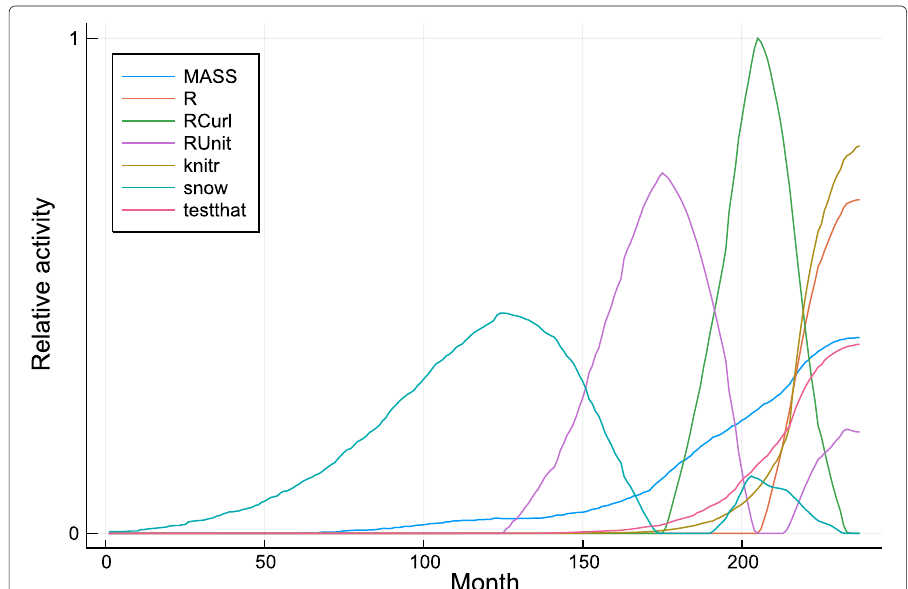
Fig. 17 Choosing the number of communities: Maven. Left: the mean pairwise adjusted mutual information of the community-node membership across repeated decompositions. 1 is a perfectly stable assignment to communities; 0 is perfectly random. The shaded area corresponds to twice the standard error of the mean. Right: the mean normalised residual sum of squares error for repeated decompositions on the Maven network against the number of components. The shaded area corresponds to twice the standard error of the mean above and below the line